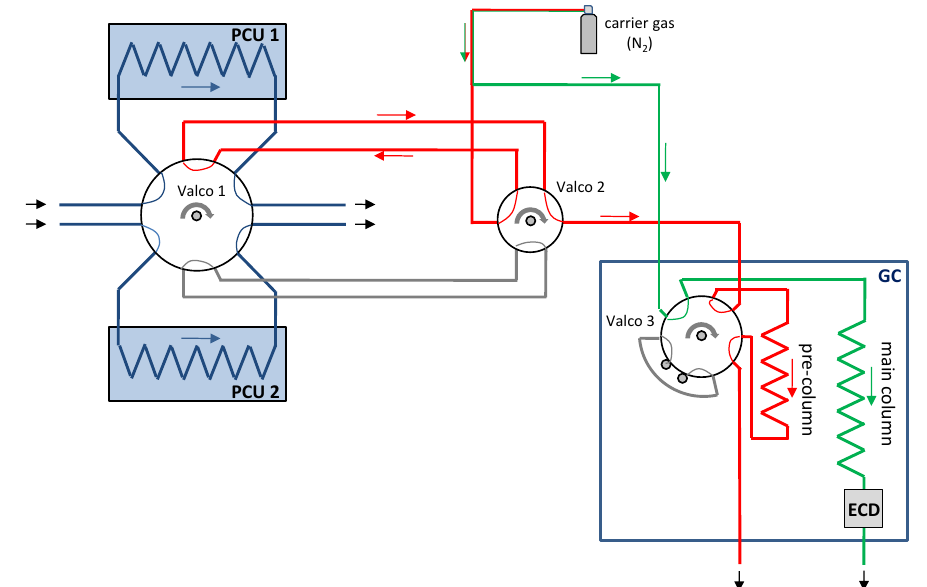
Figure 1. Simplified flow scheme of the modified GC-ECD for PAN flux measurements. During the sampling mode (shown in this example) the sample gas is drawn through two pre-concentration units (PCU 1, PCU 2). For the subsequent analysis a 12-port valve (Valco 1) is actuated, whereas a 6-port valve (Valco 2) switches between the two pre-concentration units (see text for further explanation). The analysis of PAN is performed by a commercially available GC-ECD (Meteorologie Consult GmbH,